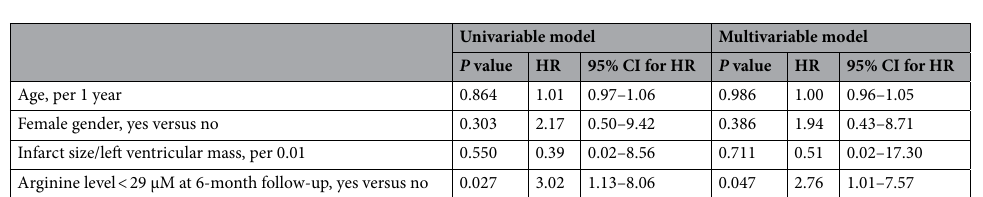
Figure 3. Prognostic value of arginine or NO x concentration. ( a ) The 6-month concentration of arginine was lower in patients with composite endpoint including death, recurrent MI or HF hospitalization during 5-year follow-up. ( b ) At 6-month follow-up arginine concentration reached the area under the ROC curve of 0.67 ( P = 0.025) for prediction of death, recurrent MI or HF hospitalization with sensitivity of 66% and specificity of 65% and ( c ) its cut-off value of < 29 µM was associated with lower event free survival. ComEnd composite endpoint, HF heart failure, MI myocardial infarction, NO x nitrite/nitrate, FU follow-up, AUC area under the receiver operating characteristic curve.